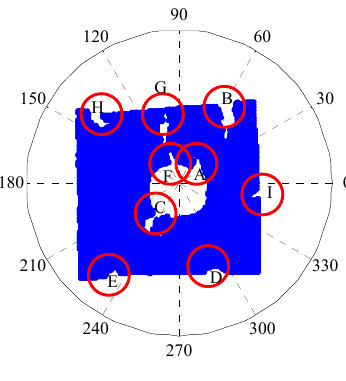
Figure 8. Direction of the coal.